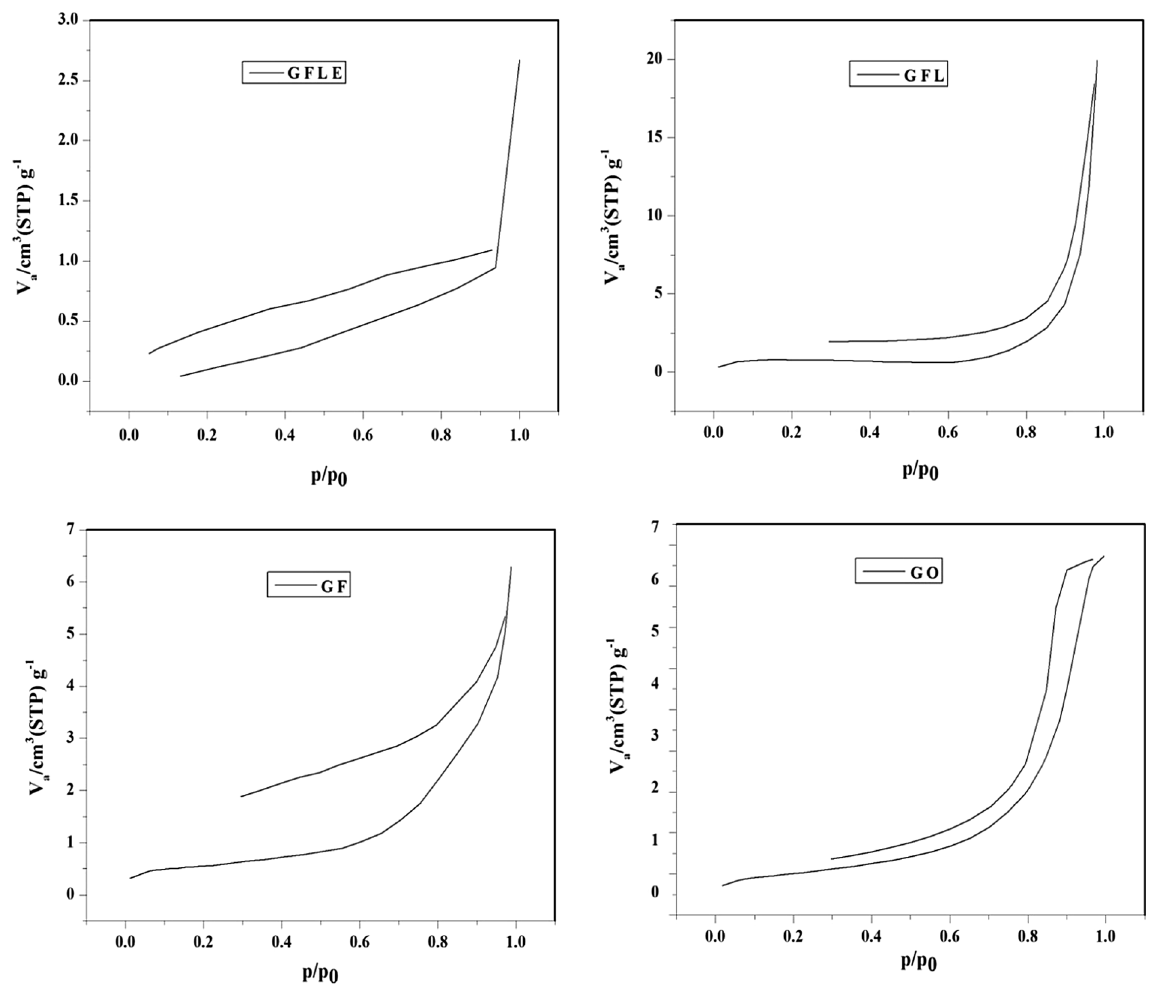
Figure 7. N 2 adsorption/desorption isotherms of the samples.